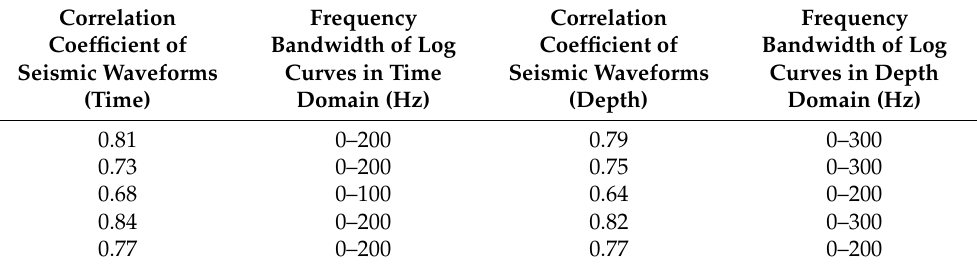
Figure 7. Comparison of prestack time-migrated seismic data ( upper ) and the reverse-time depth migrated seismic data ( lower ). Table 1. Correlation coefficient of seismic waveforms and its corresponding frequency band-width of log curves. The first line is the statistical result of Figure